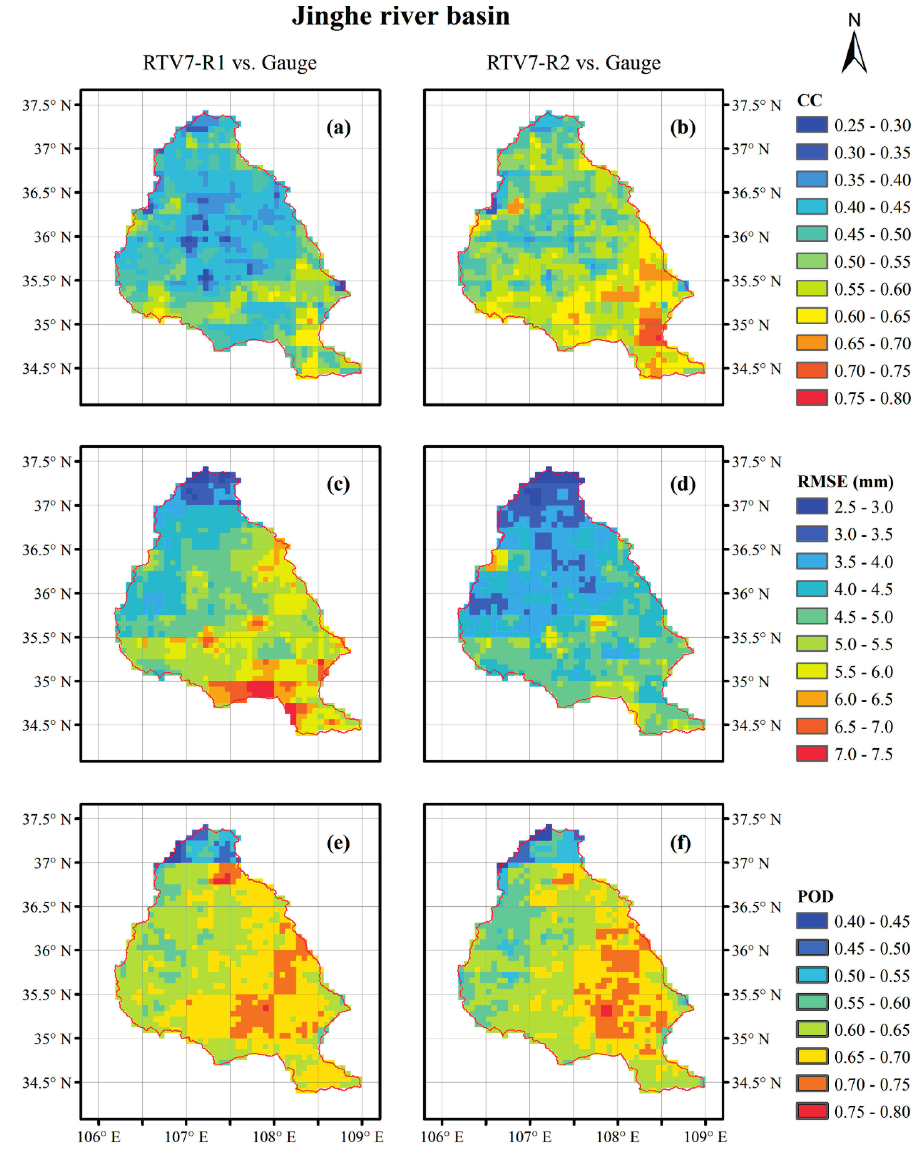
Figure 2. Spatial distributions of statistical indices computed from the ( left ) “early” RTV7-R1 and ( right ) “late” RTV7-R2 daily precipitation at 0.0625° × 0.0625° resolution over the Jinghe river basin: ( a , b ) correlation coefficient (CC), ( c , d ) root-mean-square error (RMSE), and ( e , f ) probability of detection